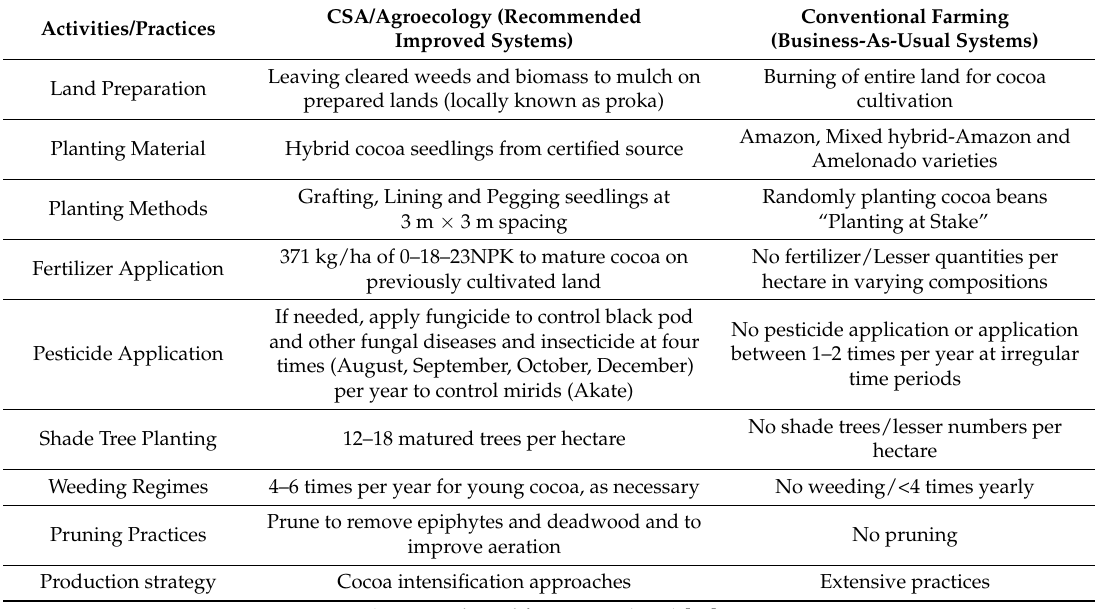
Table 2. Characteristics of CSA/Agroecology juxtaposed Conventional Practices in